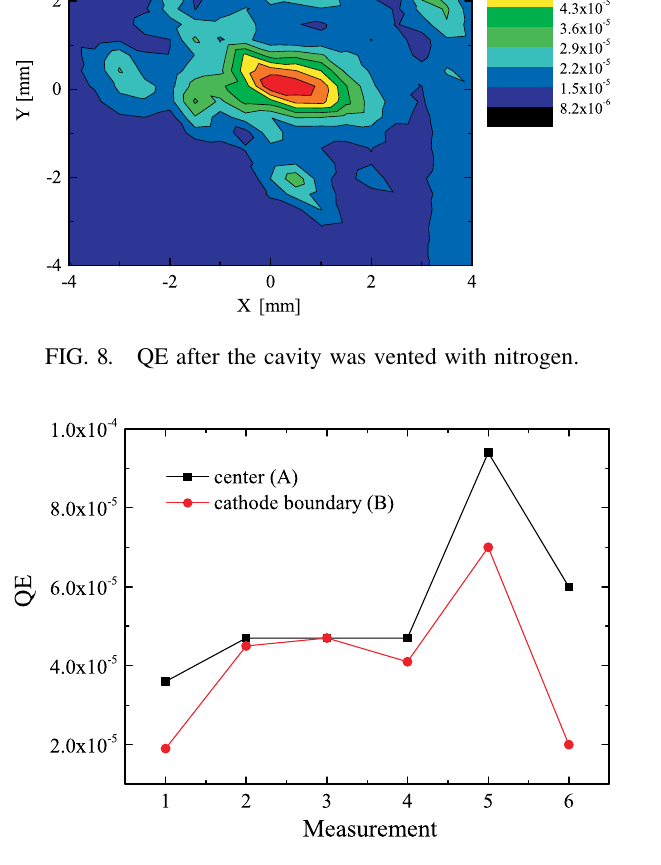
FIG. 9. History of the QE in the center (A) and near the cathode boundary (B): prior to the laser cleaning (1), after the first laser cleaning with 0 : 045 mJ = mm 2 (2), after the second laser cleaning with 0 : 087 mJ = mm 2 (3), after the third laser cleaning with 0 : 09 mJ = mm 2 (4), after the fourth laser cleaning with 0 : 23 mJ = mm 2 (5), and after the cavity was vented with dry nitrogen, warmed up and then retested (6).